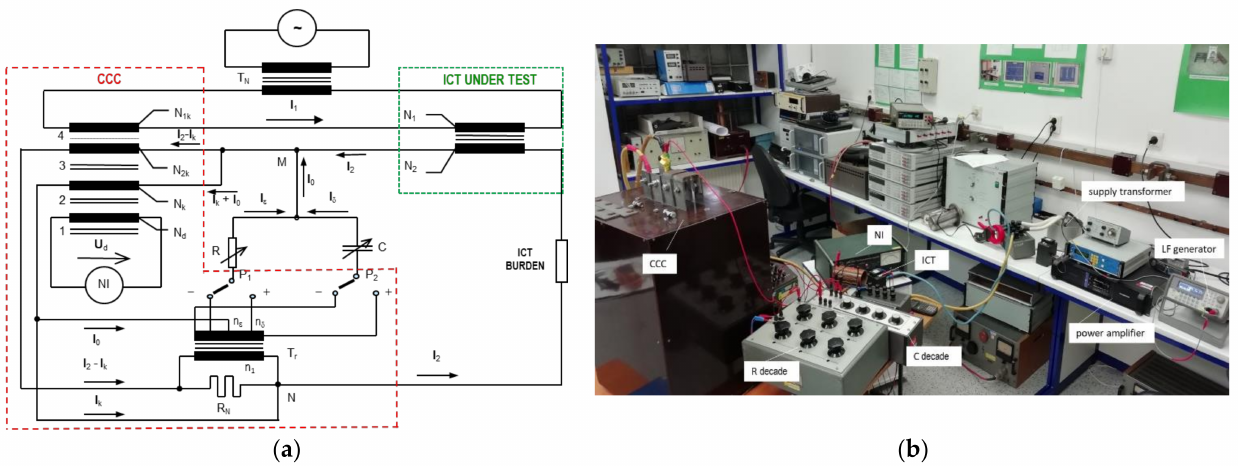
Figure 3. Block diagram ( a ) and picture ( b ) of the generation and measurement setup for inductive CT characterization with CMI